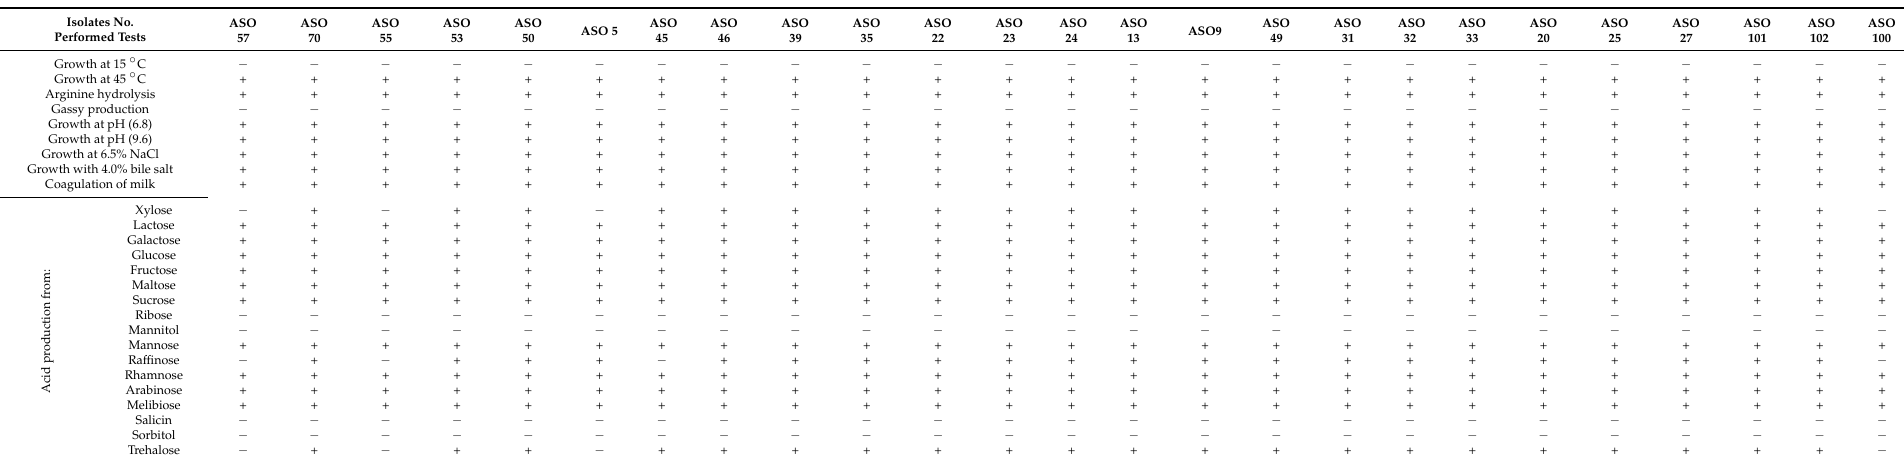
Table 3. Physiological and biochemical characteristics of rod lactic acid